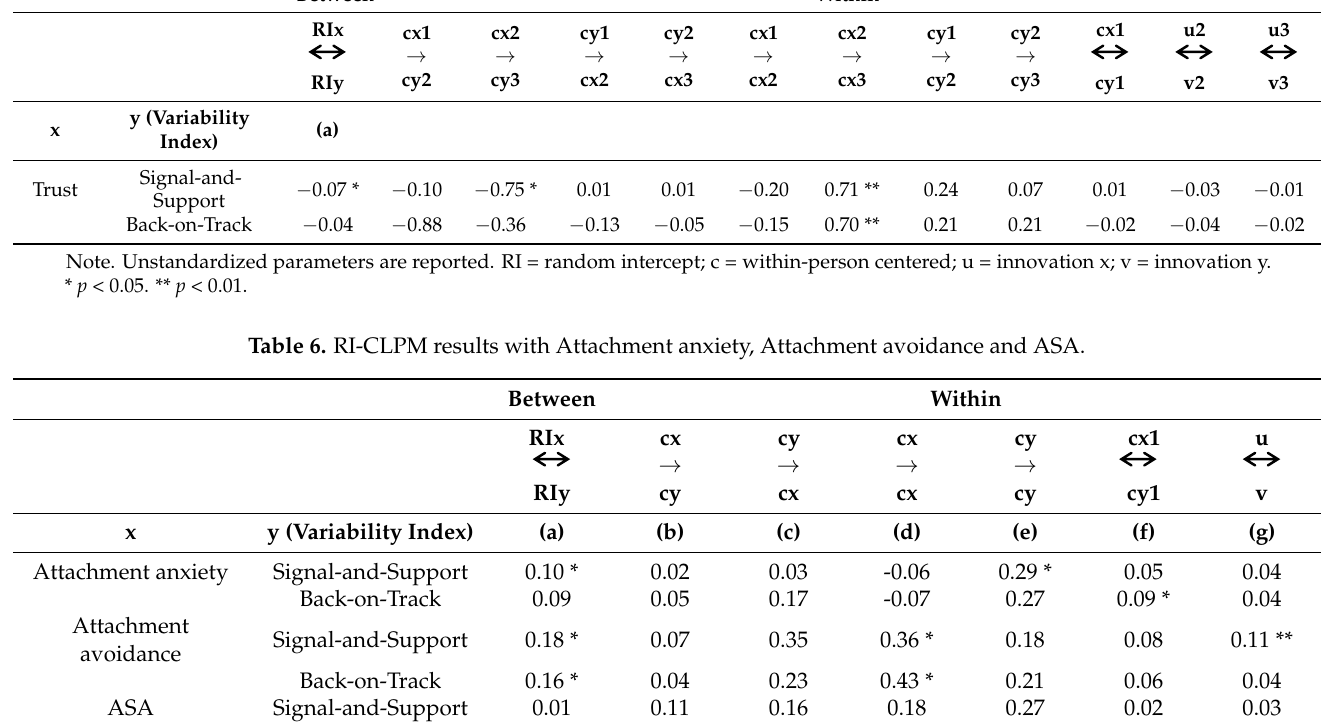
Table 5. RI-CLPM results with Trust.